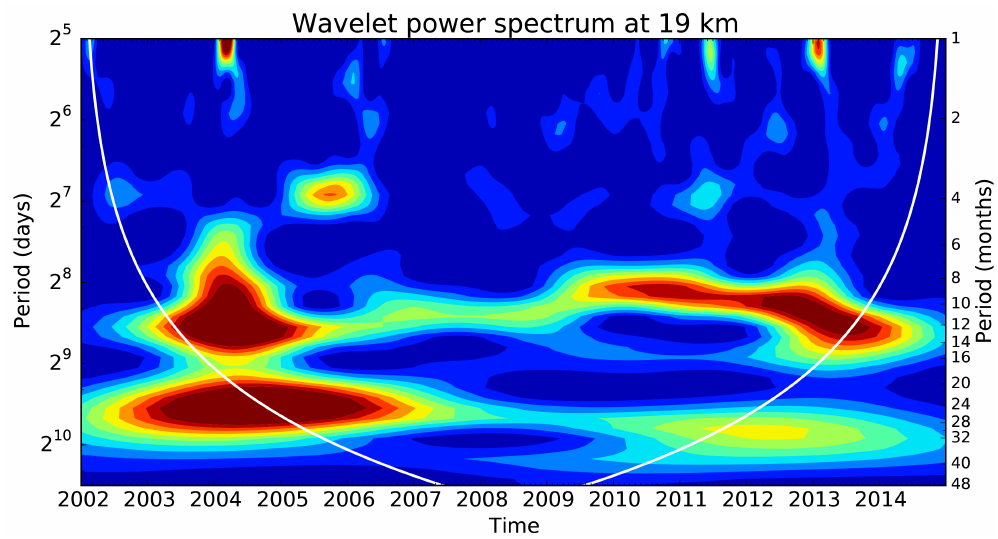
Figure 10. Wavelet power spectrum of daily Kelvin-wave variance at 19km from January 2002 to December 2014. The white line indicates the cone of influence. The period shown on the right y axis (period in months) is calculated assuming 30 days per